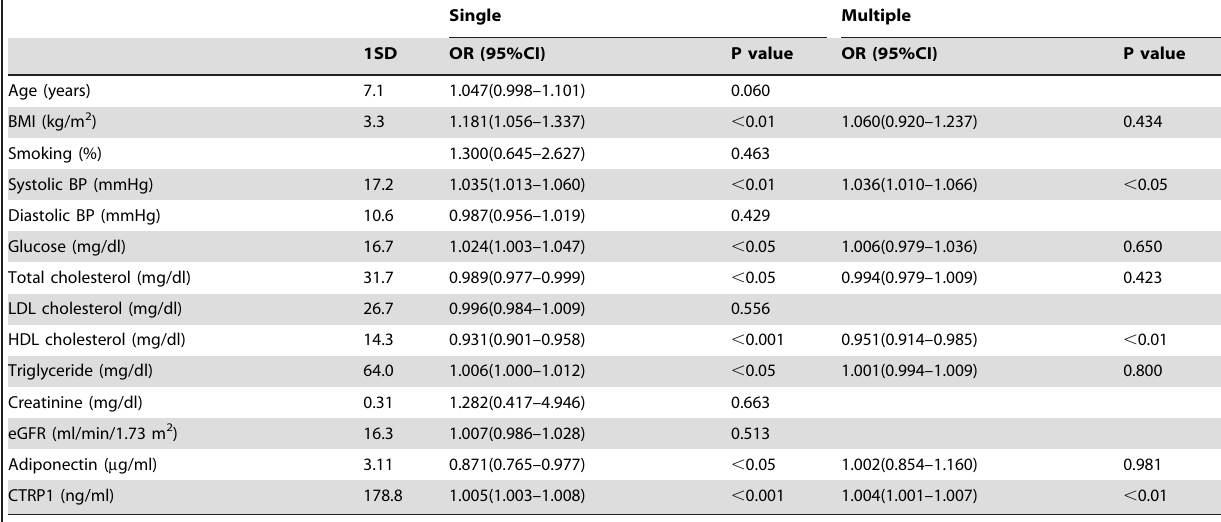
Table 3. Association with